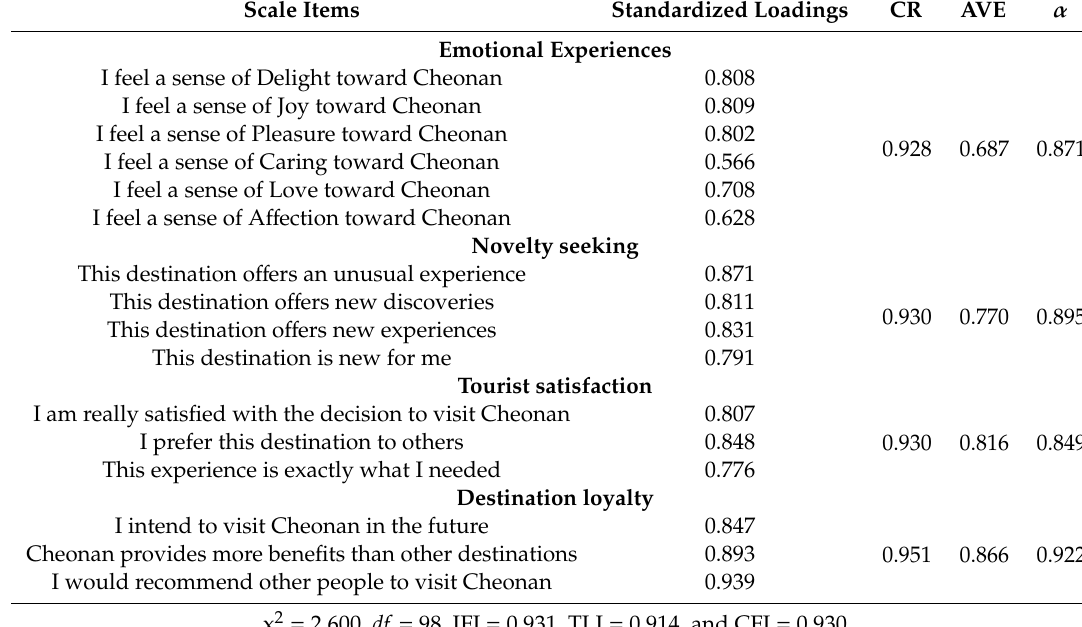
Table 1. Confirmatory factor analysis (CFA) results for the measurement model.